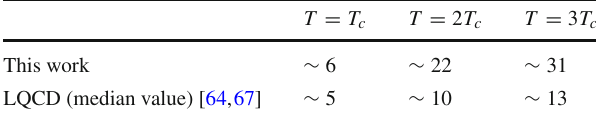
Table 2 Summary of the different models for 2 π T D s at desired tem- perature